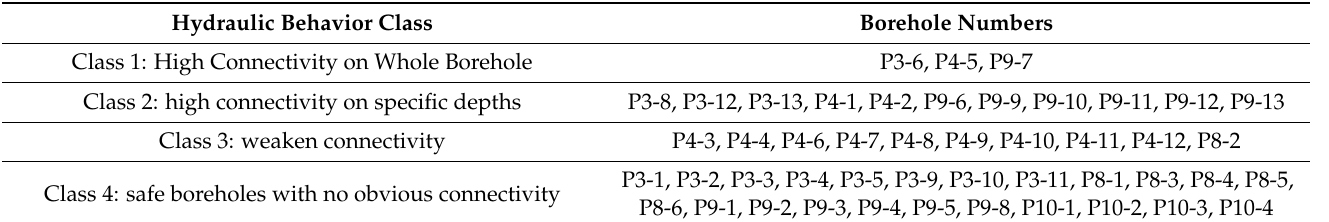
Table 1. Classification result of boreholes by seepage